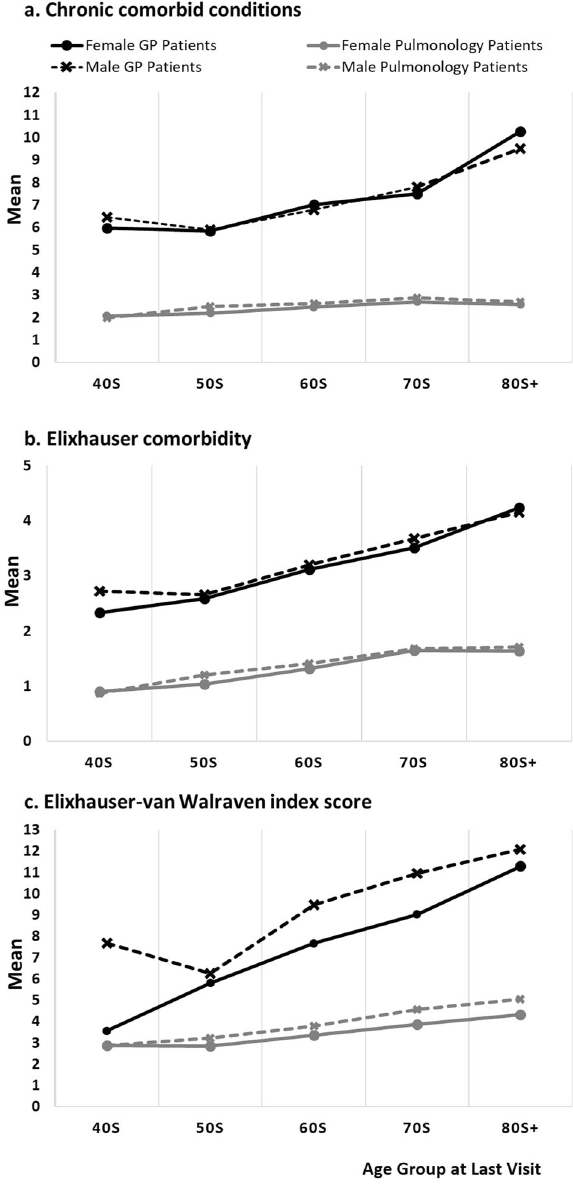
Fig. 2 Chronic comorbid conditions (CCC), Elixhauser, and Elixhauser-vW index by gender, age group, and practice type. Figures represent mean number of comorbidities for each age group separated by gender and practice type.